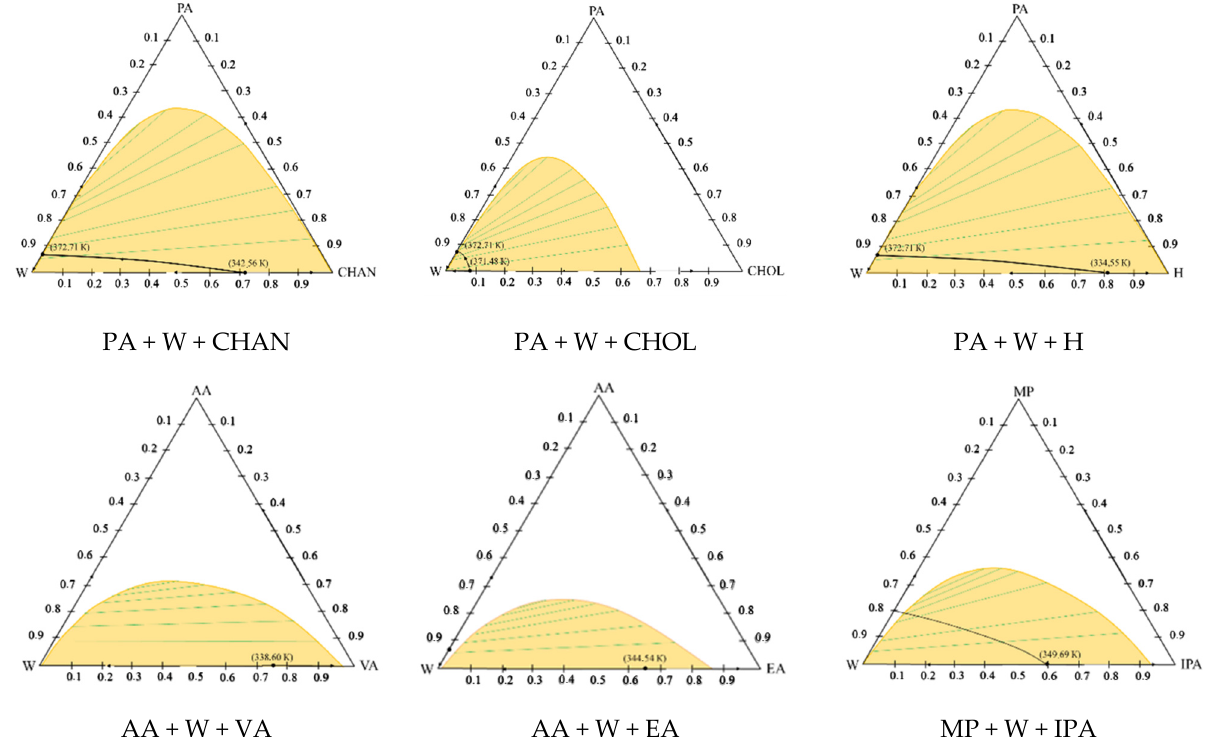
Figure 1. Phase diagram of derived ternary systems (“original binary mixture + entrainer (HAD)”) at 101.3 kPA (LLE is given at 293 K).